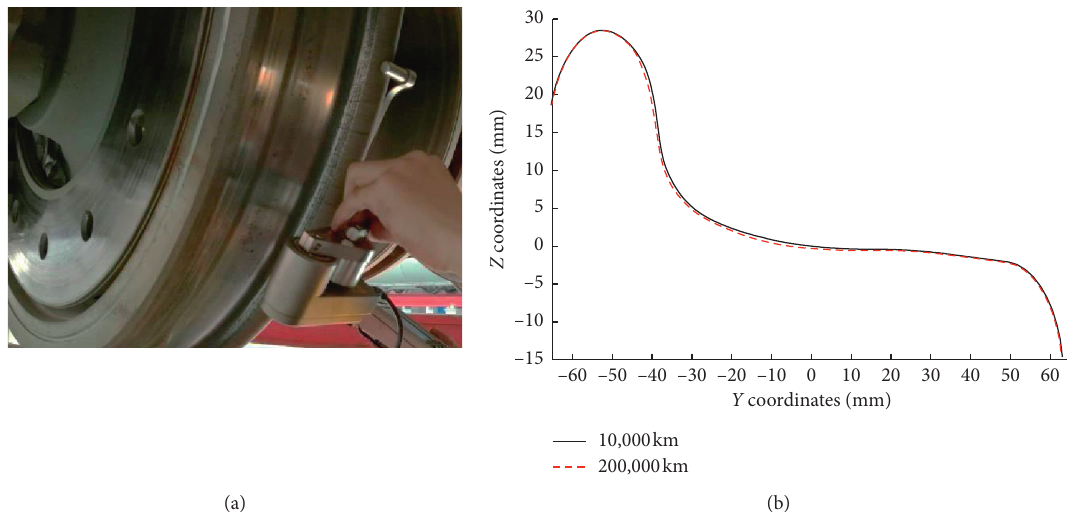
Figure 3: Wheel wear measurement: (a) wheel profile measurement instrument MiniProf; (b) measured wheel tread